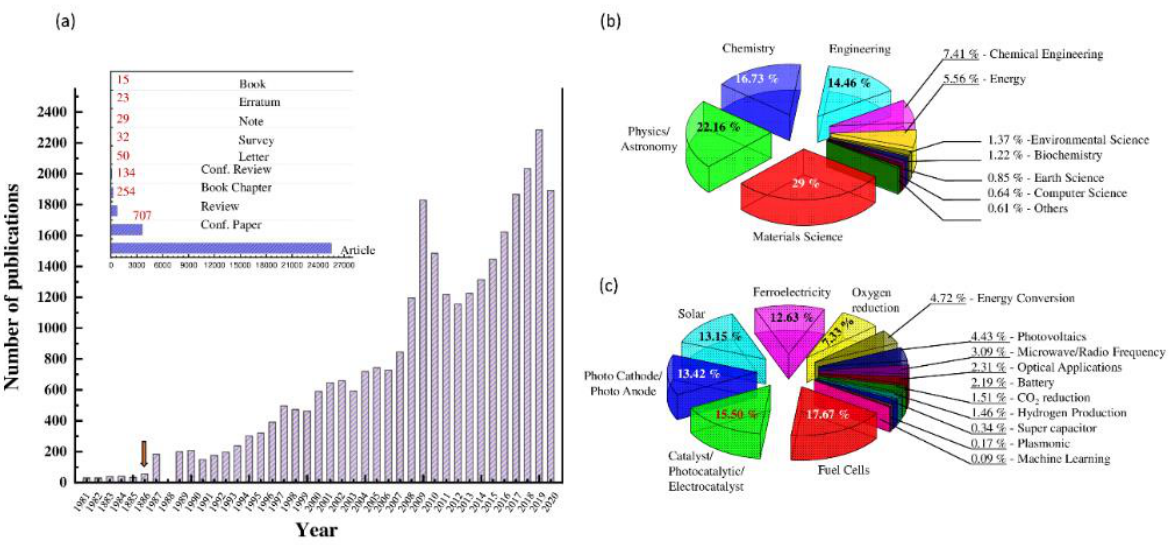
Figure 1. ( a ) Latest studies on the oxide perovskite field and their respective distribution of the key words employed and histogram of the type of documents, in the inset. ( b ) Distribution of the publications per discipline and per ( c ) applications.